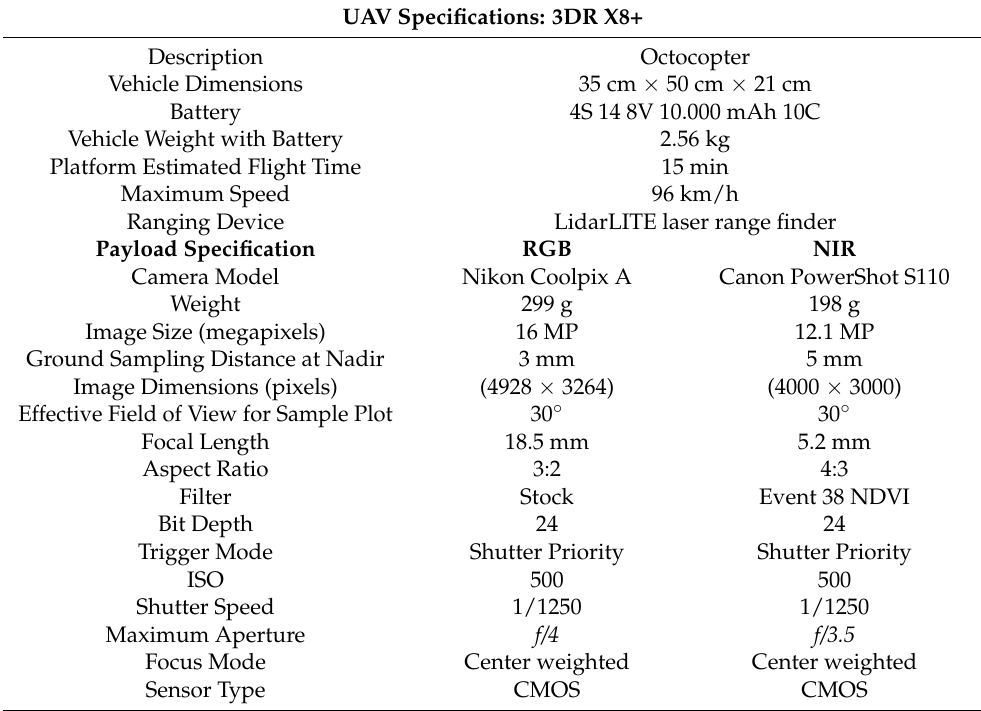
Figure 3. ( a ) The 3DR X8+ unmanned aerial vehicle (UAV) can collect density samples at a rate of 45 s/ha. ( b ) The sample-based flight plan used for this study enables a rapid assessment of large forestry blocks. The UAV moves to a sample plot waypoint, descends to a 15 m altitude above ground level (AGL), captures an image, ascends, and continues to the next waypoint. Table 1. Unmanned aerial vehicle (UAV) and camera specifications. RGB—red green blue. NIR—near-infrared; CMOS—complementary metal-oxide-semiconductor; NDVI—normalized difference vegetation